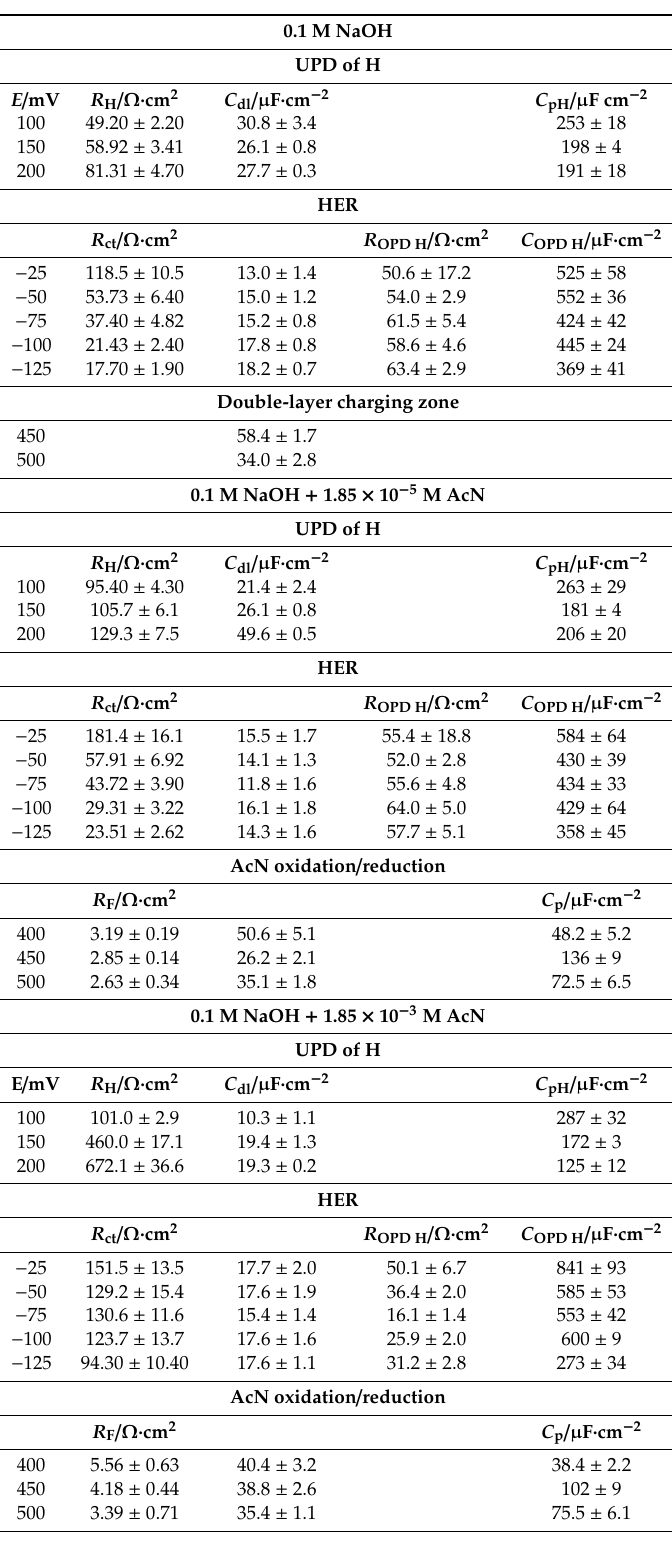
Table 2. Resistance and capacitance parameters for UPD of H, HER and AcN fairly reversible oxidation / reduction processes on Pt polyoriented single-crystal sphere electrode surface in contact with 0.1 M NaOH and in the presence of acetonitrile (at 293 K), obtained by fitting the equivalent circuits shown in Figure 3a through Figure 3c to the recorded impedance data (recorded values of dimensionless ϕ parameters for the CPE circuit components oscillated between 0.79–0.99 and 0.87–0.99 for UPD of